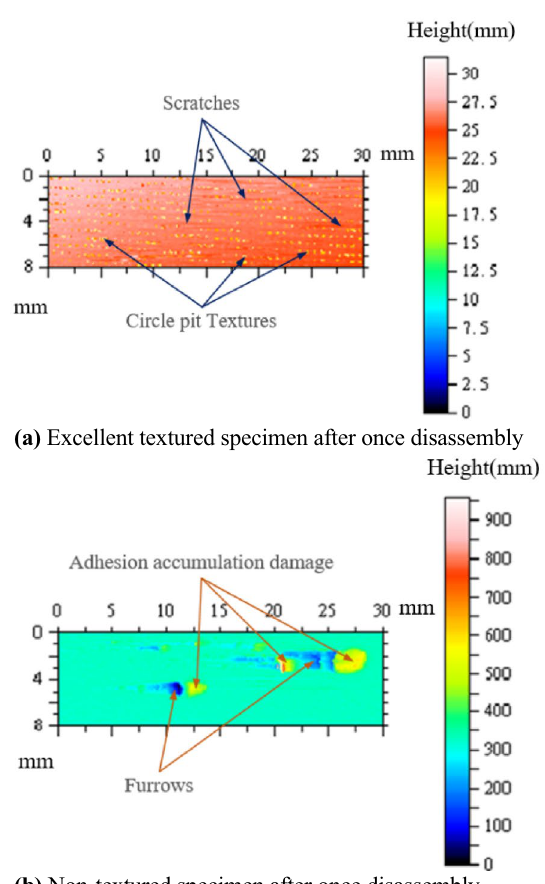
Figure 5 Surface topography image of disassembly damage